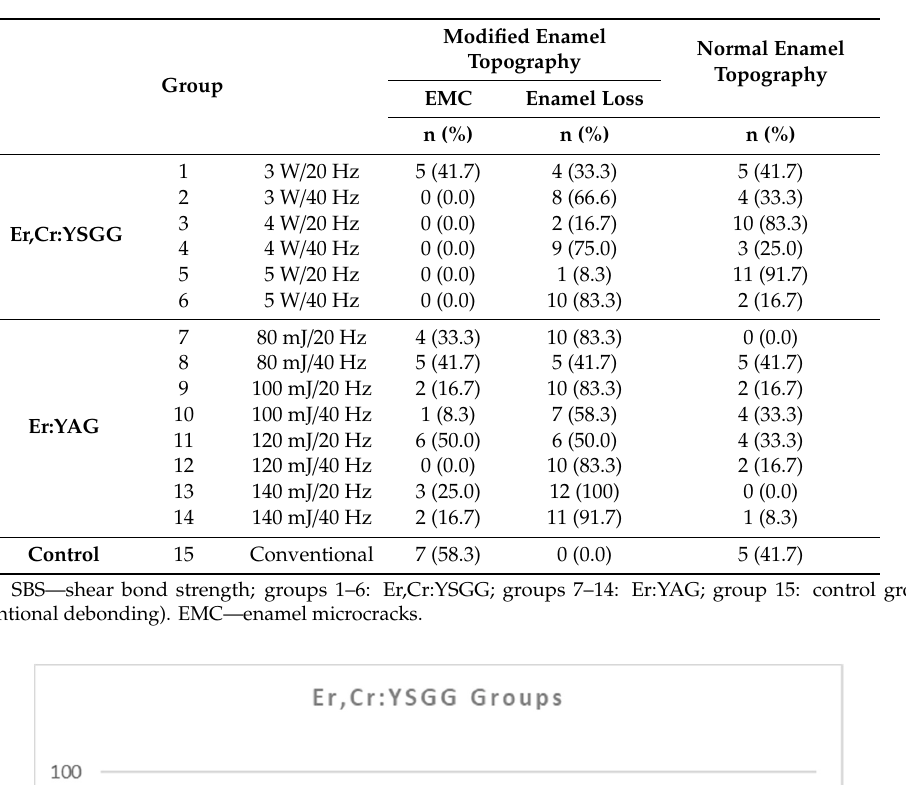
Table 1. Distribution sample by enamel status post debonding (n = 180).